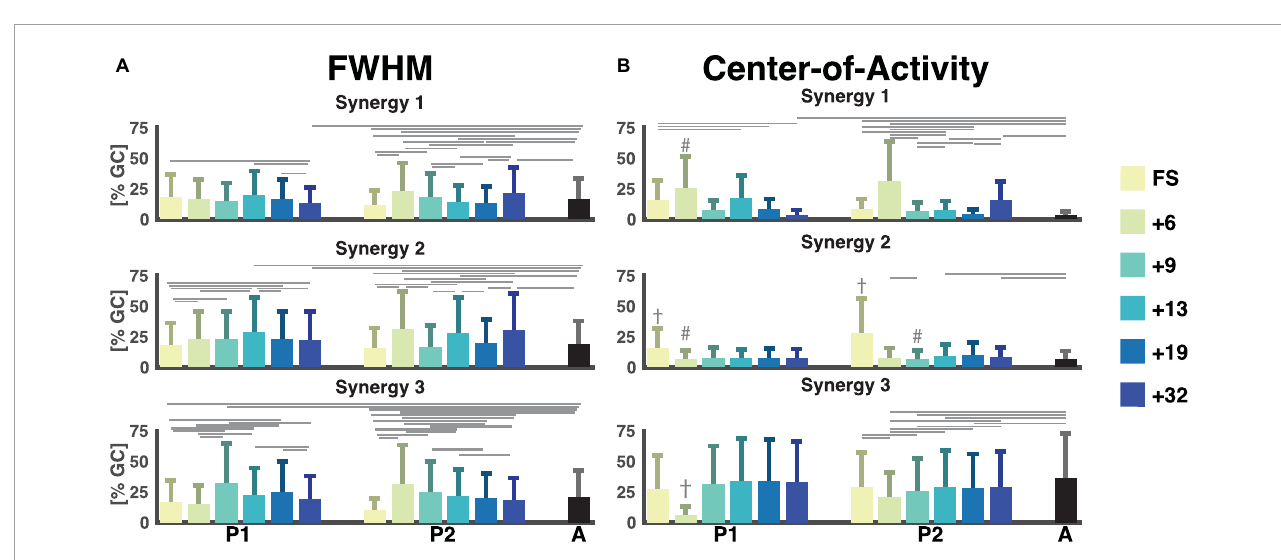
FIGURE6 Full-width half-maximum and center-of-activity of muscle synergies. Color notation as to the right. (A) The full-width half-maximum (FWHM) was calculated for the main peak of each stride for each muscle synergy. It is represented as a percentage of the gait cycle. (B) The center-of-activity (CoA) were was expressed as the percentage of the gait cycle. The horizontal lines represent a significant difference, p < 0.007 within a participant and the adults. The dagger ( † ) represents a significant difference between session and all other sessions. A hash (#) represents a significant difference between session and all later sessions and adults. GC: gait cycle, FWHM: full-width at half-maximum, A: adults, FS: first steps, +6, +9, +13, +19, +32 refers to the number of months since onset of independent walking.